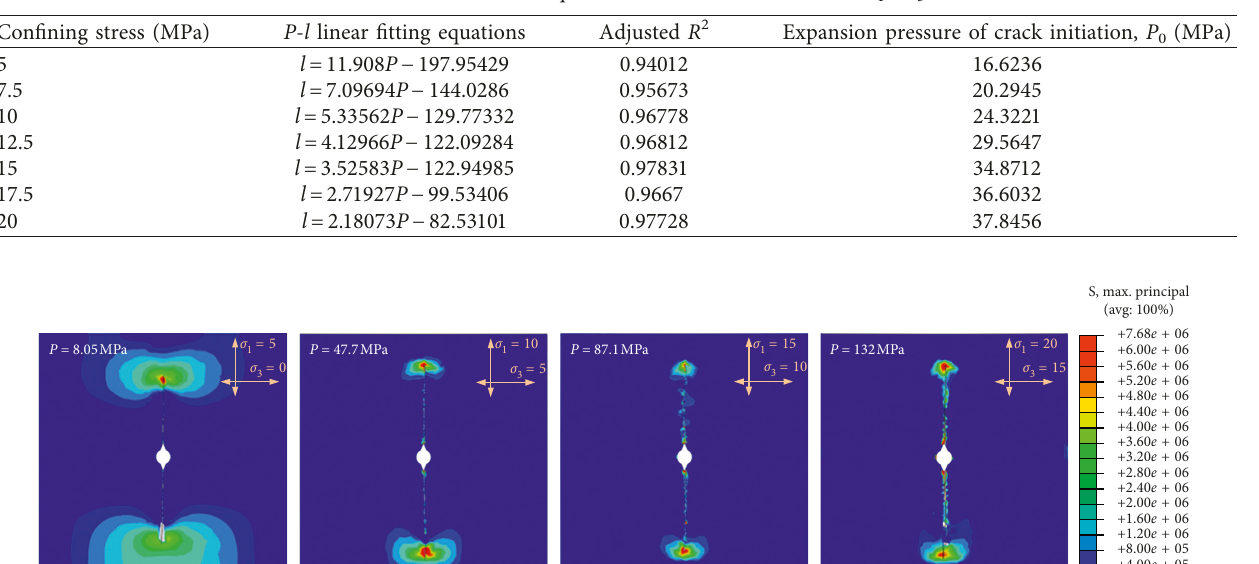
Figure 14: (a) The variations of crack length with increasing SCA expansion pressure under different bidirectional isobaric stress fields. (b) Variations of crack initiation pressure P 0 and the slope of P - l linear fits a l as confining stress increases. Table 3: The P - l linear fit equations under the conditions of σ 1 (cid:31) σ 3 .